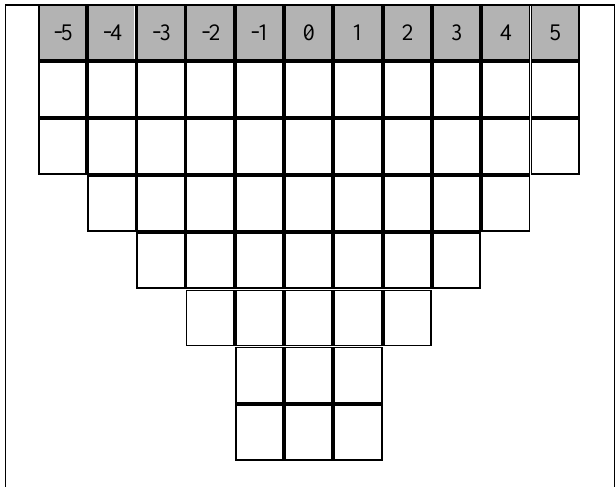
Figure 2: The response grid Data capture and processing